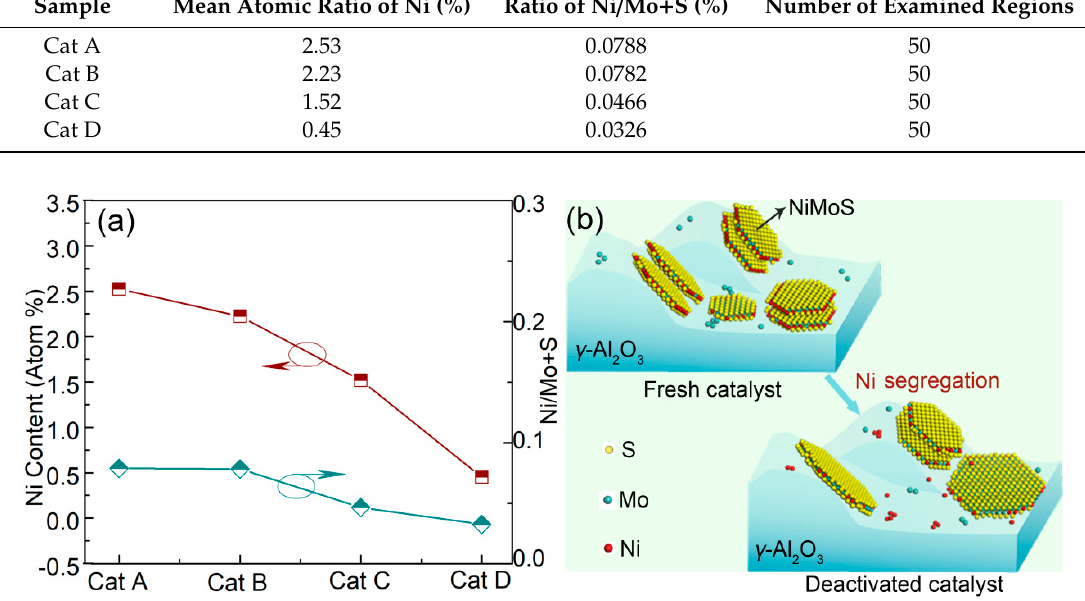
Figure 4. ( a ) Variations in average Ni atomic ratio and Ni/Mo+S on Type I regions as a function of different catalysts, ( b ) Schematic illustration of Ni segregation during catalysis.